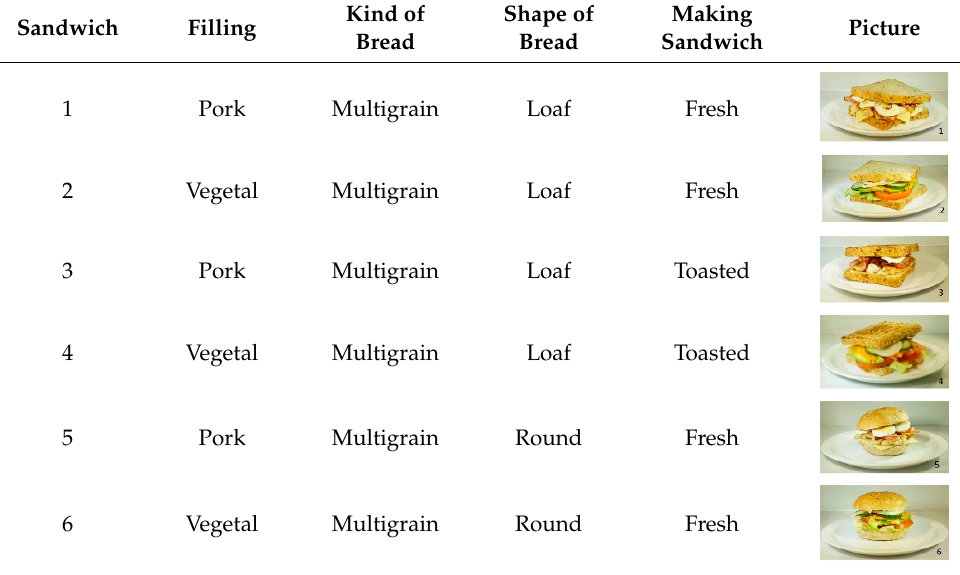
Table 1. Description of the sandwiches evaluated by consumers following the experimental design.